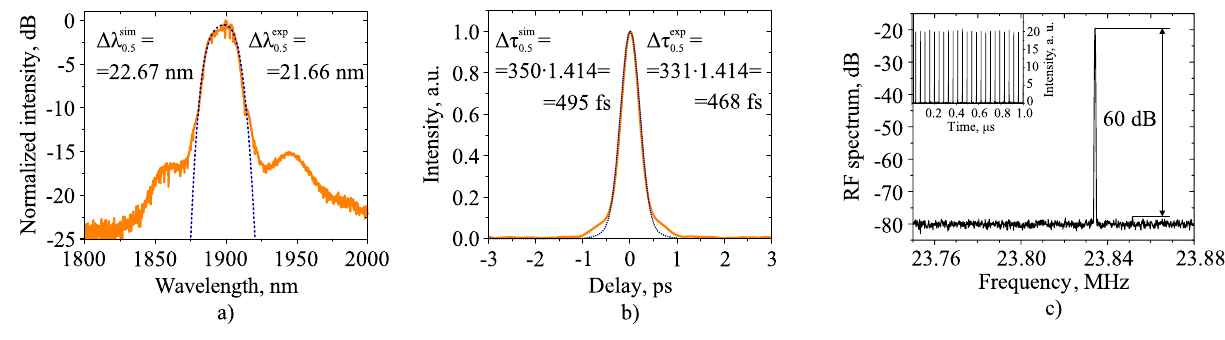
Figure 3. ( a ) Spectrum; ( b ) intensity autocorrelation trace; orange curves represent experimental data, blue dotted curves represent results of numerical simulation; ( c ) radio-frequency spectrum of achieved pulses; inset shows pulse train captured by oscilloscope.